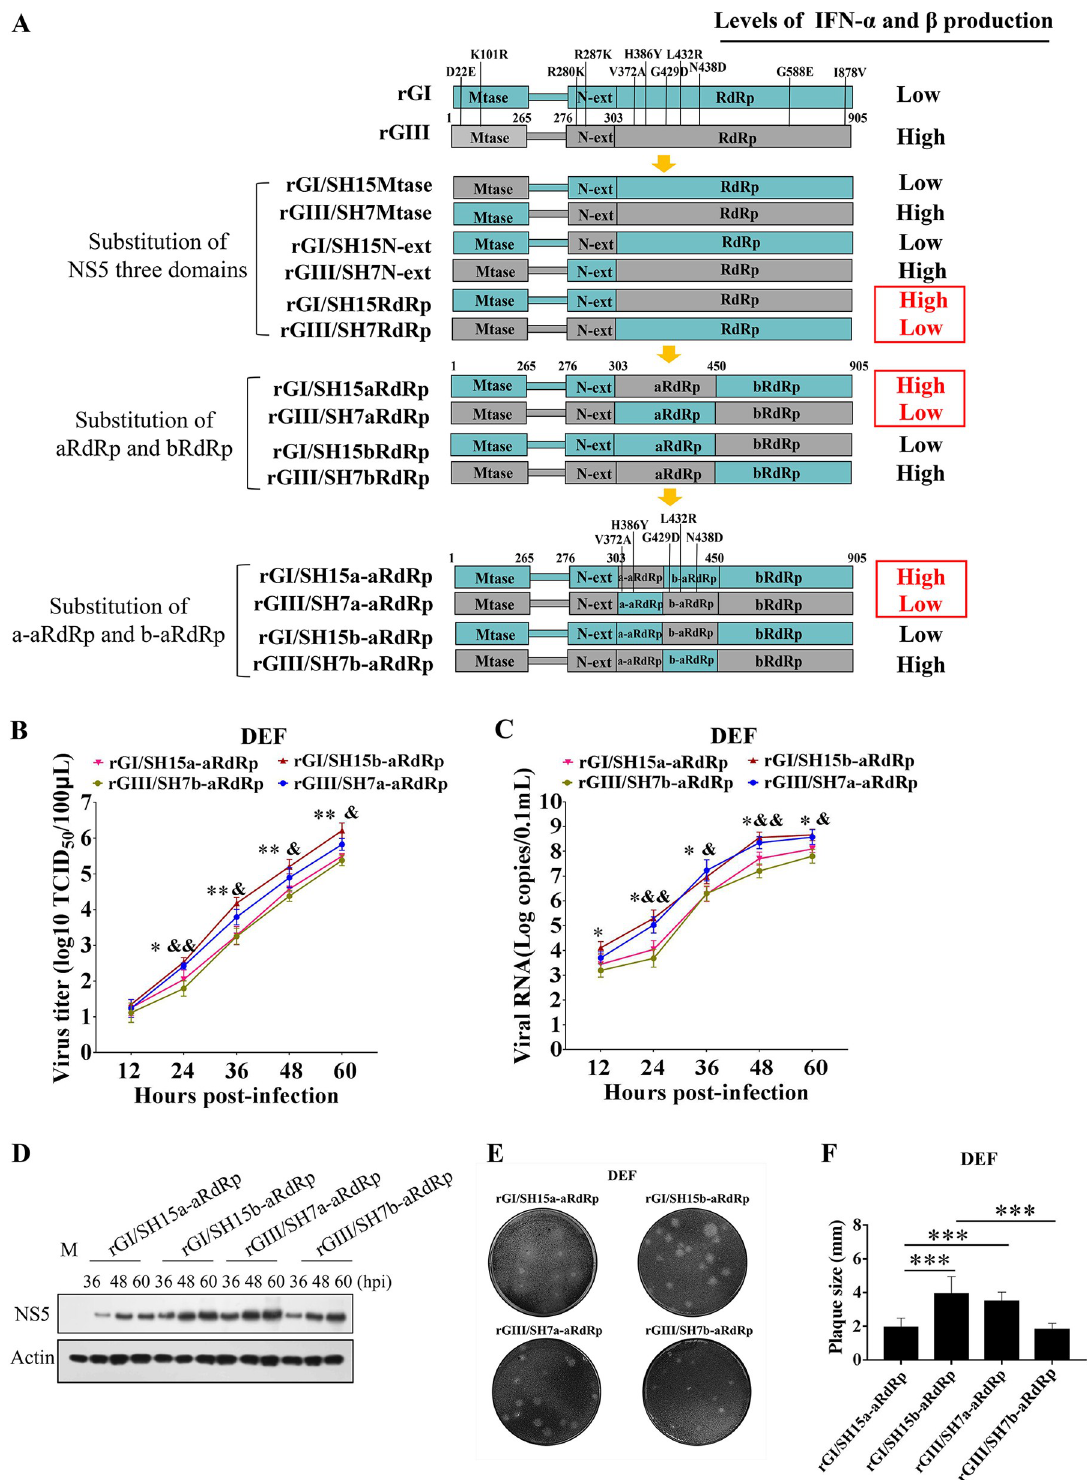
Fig 6. Identification of the region of NS5 responsible for the differences in IFN- α and β induction and replication efficiency. (A) Schematic diagram of chimeric recombinant viruses used in this study. Viral proteins of GI and GIII strains are highlighted in blue and gray, respectively. (B, C and D) DEF were infected with the indicated chimeric viruses at 0.01 MOI and collected at the indicated time points for analysis of replication efficiency. The replication titers in the supernatants were titrated with TCID 50 assays in BHK cells